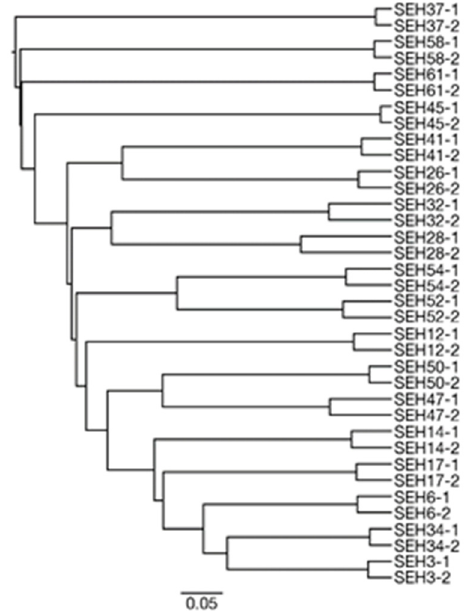
Figure 2. Dendrogram of all samples according to the unweighted pair group method with arithmetic means (UPGMA) based on the beta diversity of community structures.